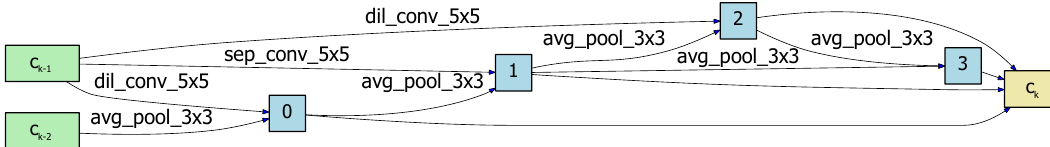
Figure 8. The normal cell searched by NAS-HRIS on GID_Dataset.